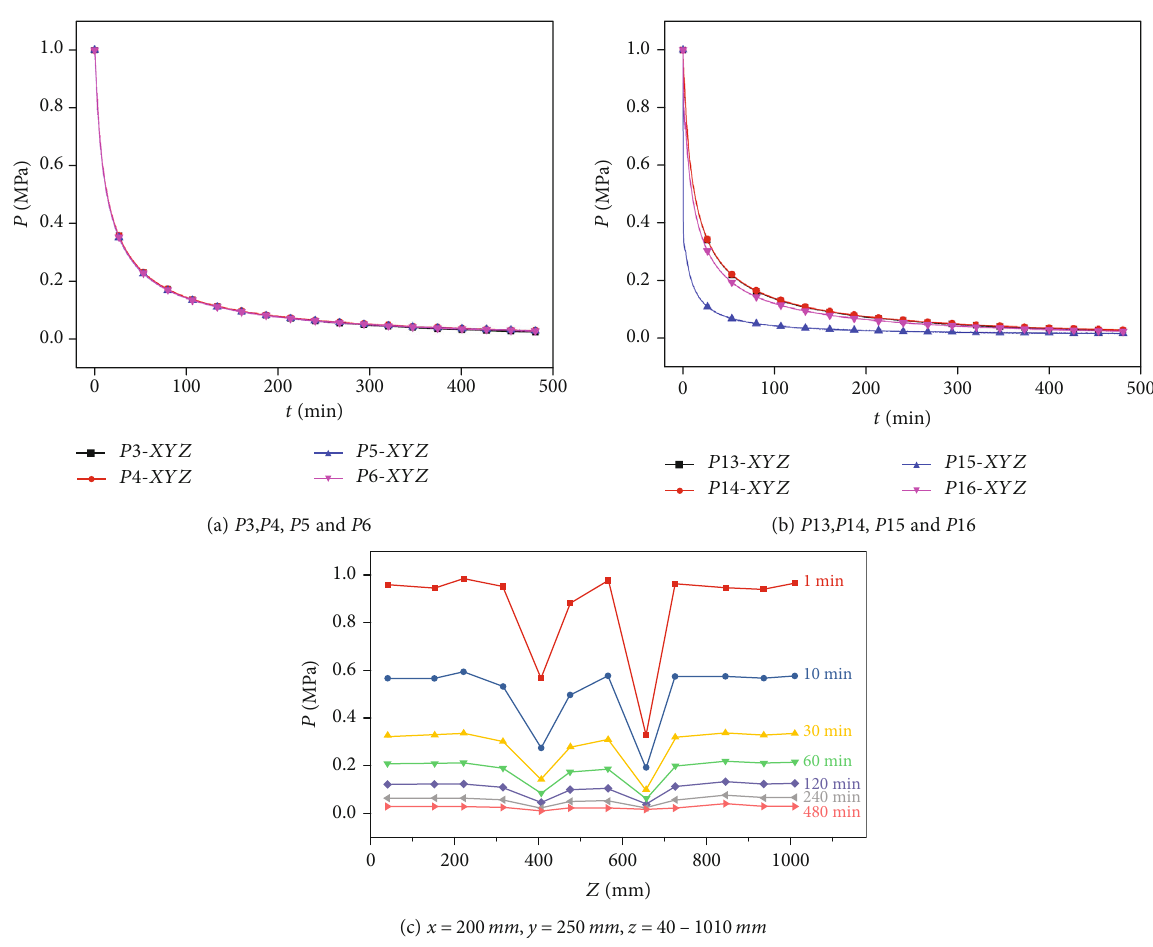
Figure 3: Evolution of gas pressure during gas drainage.